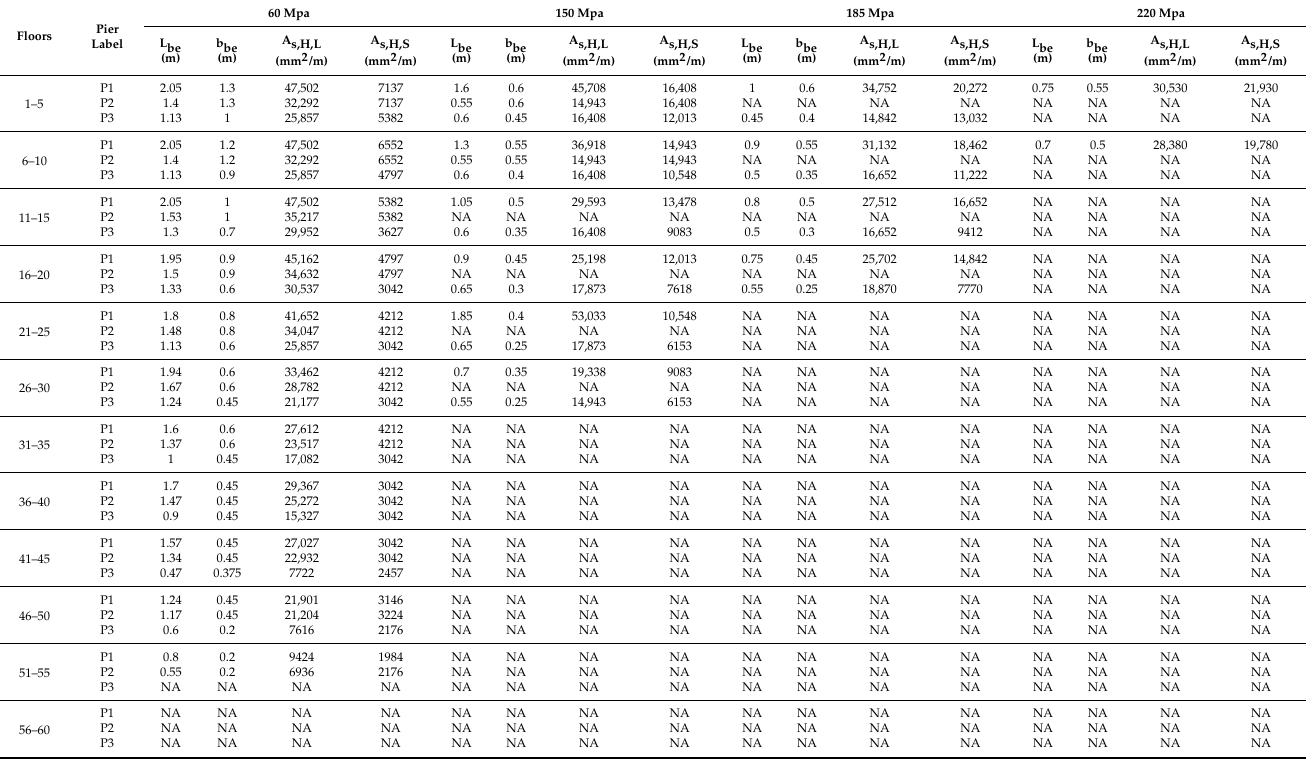
Table 5. Boundary element design summary.